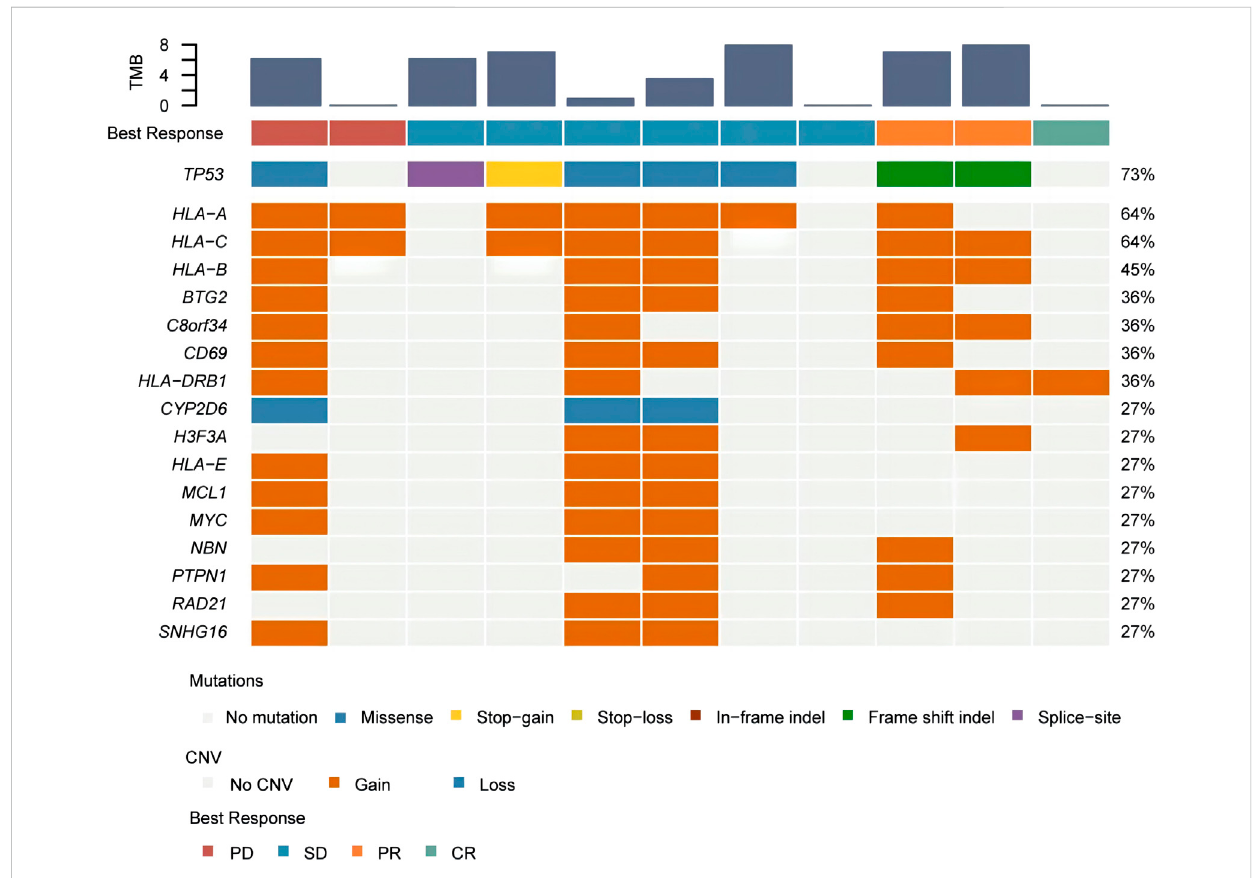
FIGURE 2 Genes with a mutation frequency greater than